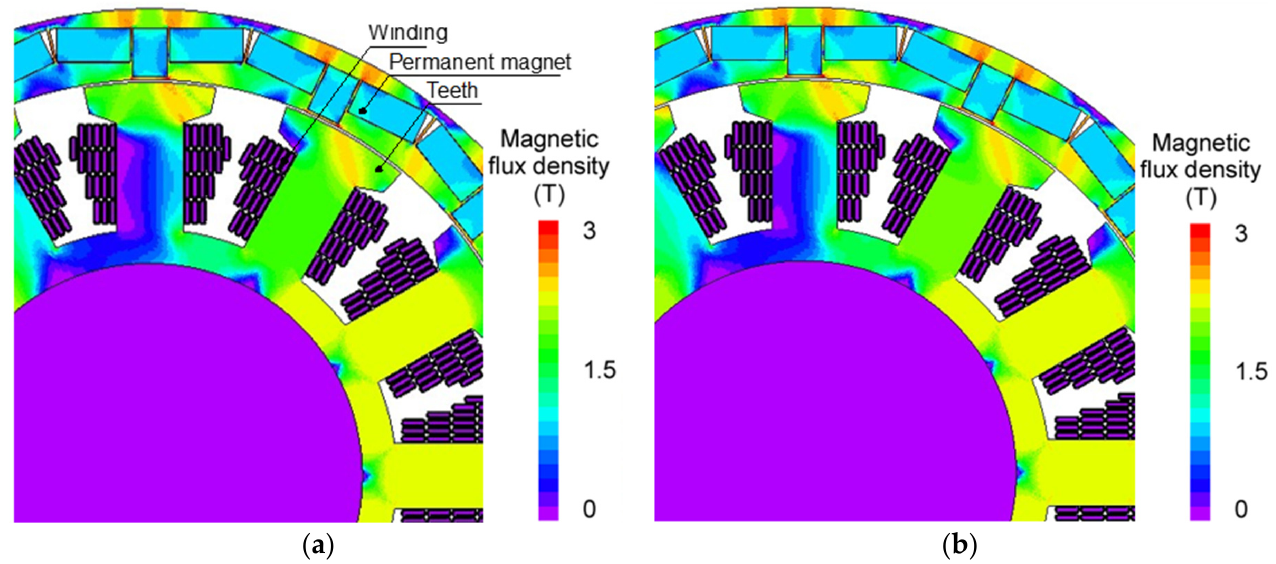
Figure 17. Magnetic flux density distribution in the motors ( P o = 10 kW, N r = 10,000 rpm) ( a ) Fe–Si–Al tape windings; ( b ) virtual tape windings.